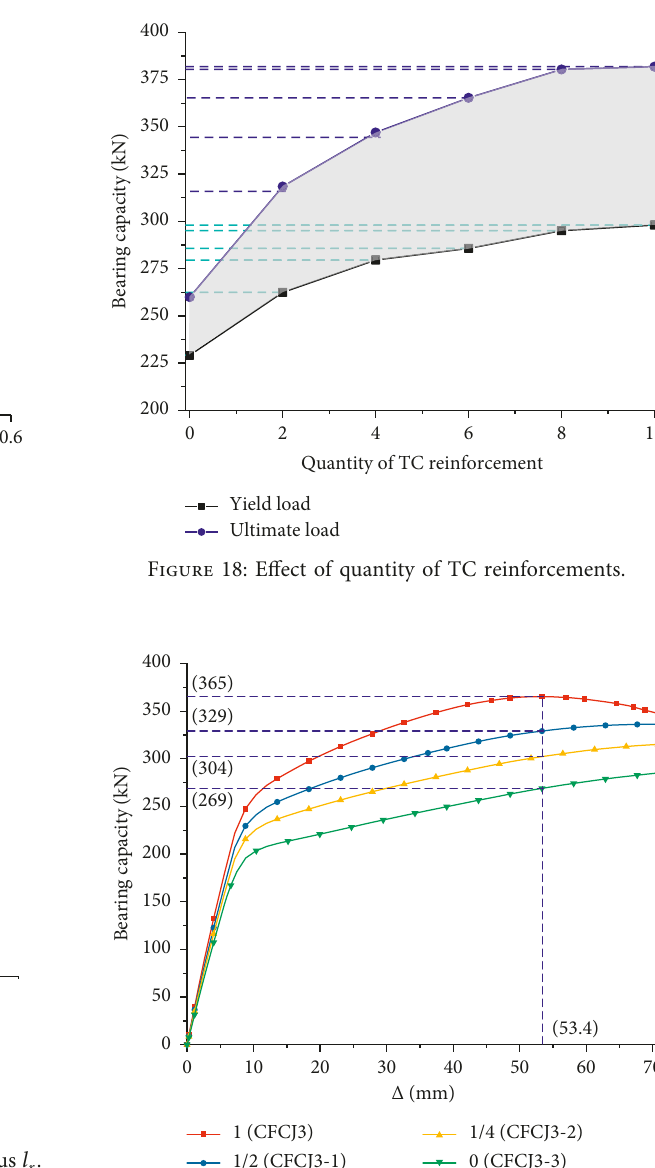
r . Figure 19: Comparison of the bearing capacity versus beam-tip